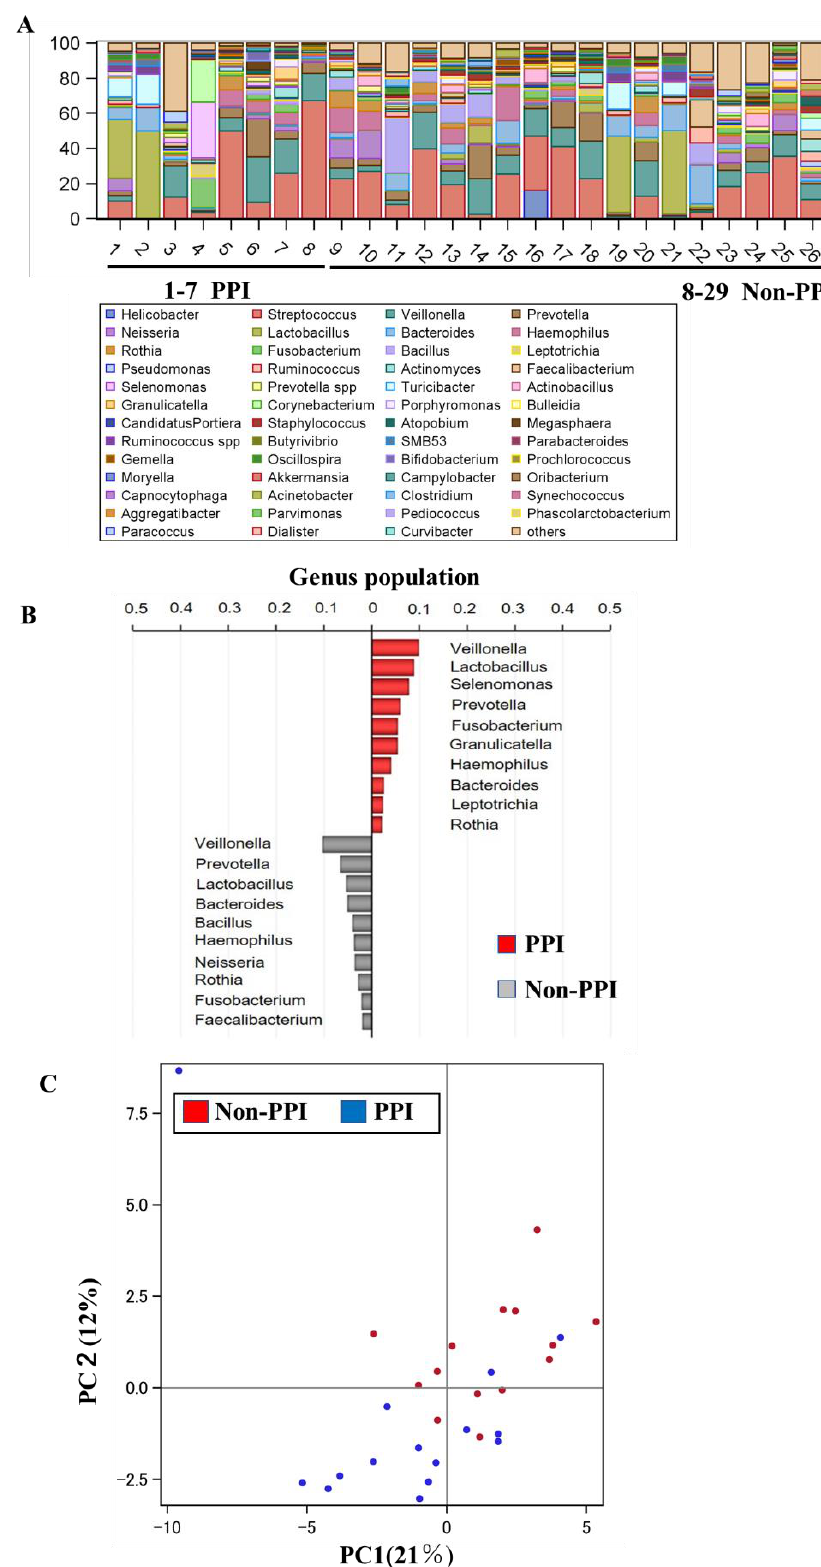
Figure 3. Gastric flora analysis. ( A ) Taxonomy, genus level. Comparison between proton pump inhibitor (PPI) and non-PPI; ( B ) The ten most relevant genus taxa between PPI and non-PPI; ( C ) Principal coordinate analysis between PPI and non-PPI.